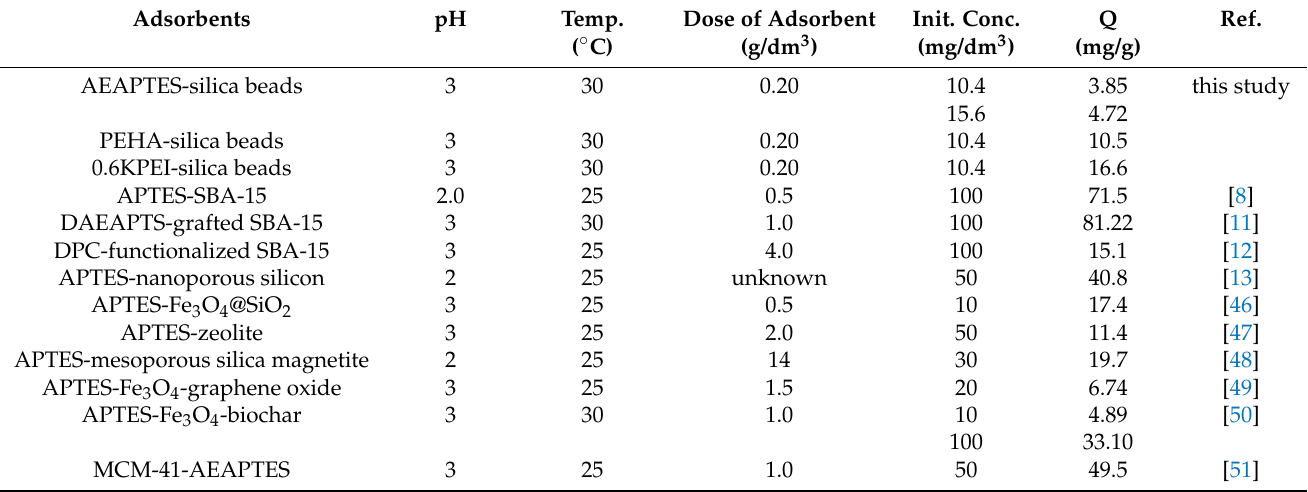
Table 9. The comparison with Cr(VI) ion adsorption capacities of adsorbents functionalized with various aminosilane coupling agents. pH Temp. Dose of Adsorbent Init.